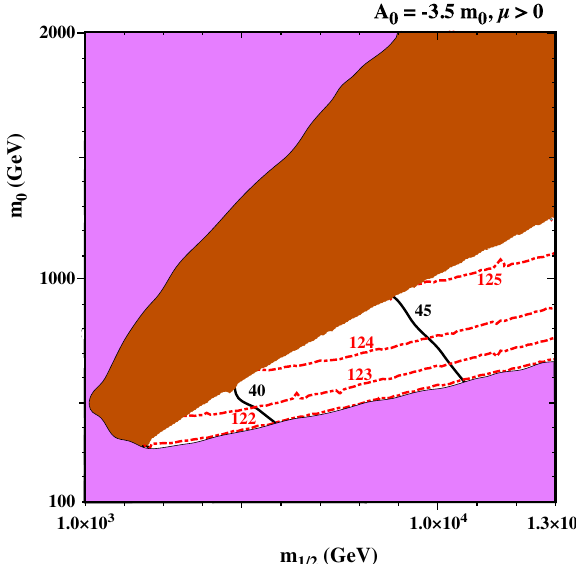
Fig. 4 Higgs mass contour plot in the plane ( m 1 / 2 - m 0 ) for the “ large λ λ = ( 0 . 01 , 0 . 6 , 0 . 6 ) . The colour code is the same N ” scenario with N as in Fig. 2. In this scenario a light neutralino is the LSP in the white areas. Red dashed contours account for the Higgs mass (in GeV), while the black lines represent the value of tan β